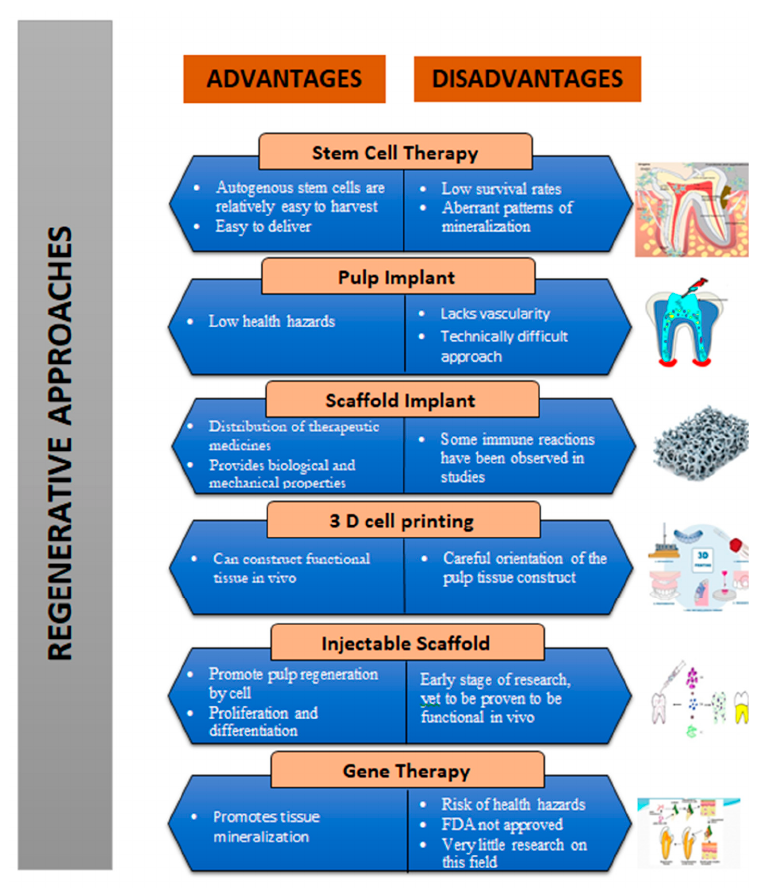
Figure 3. Summary of the advantages and disadvantages of the regenerative approaches in endo- dontics.